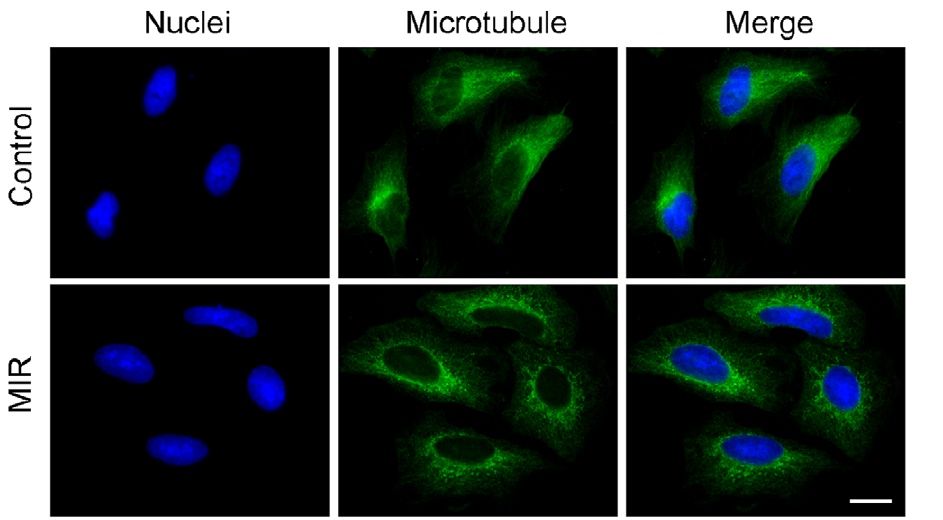
Figure 4. Effect of MIR exposure on the microtubule networks of A549 cells. Cells were seeded onto glass coverslips in 12-well plates, exposed to MIR for 48 hours, fixed for staining and visualized by fluorescence microscopy. Microtubules were labeled with a –tubulin antibody and the corresponding FITC–conjugated secondary antibody (green), and nuclei were labeled with DAPI (blue). Scale bar represents 10 m m.